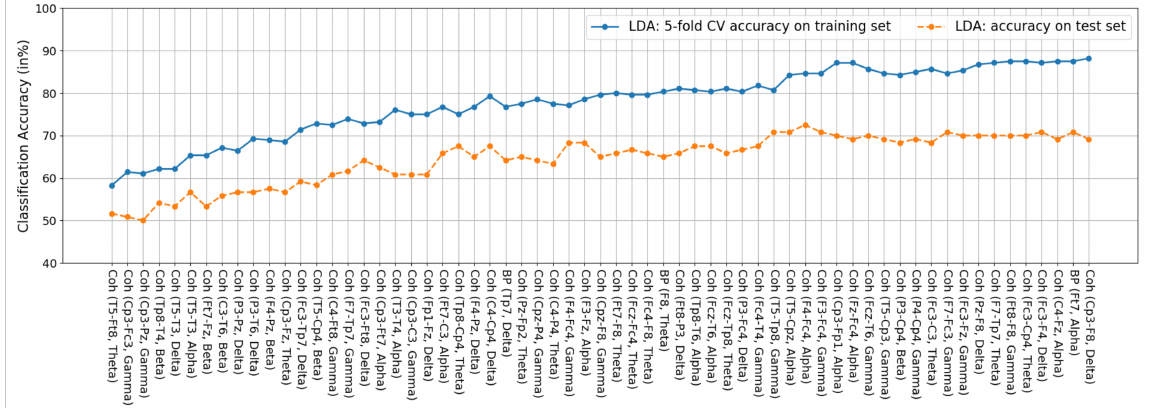
Figure A2. Features of the LDA classifier. Among the 63 features, 60 are coherence features and the remaining three are all BP features.